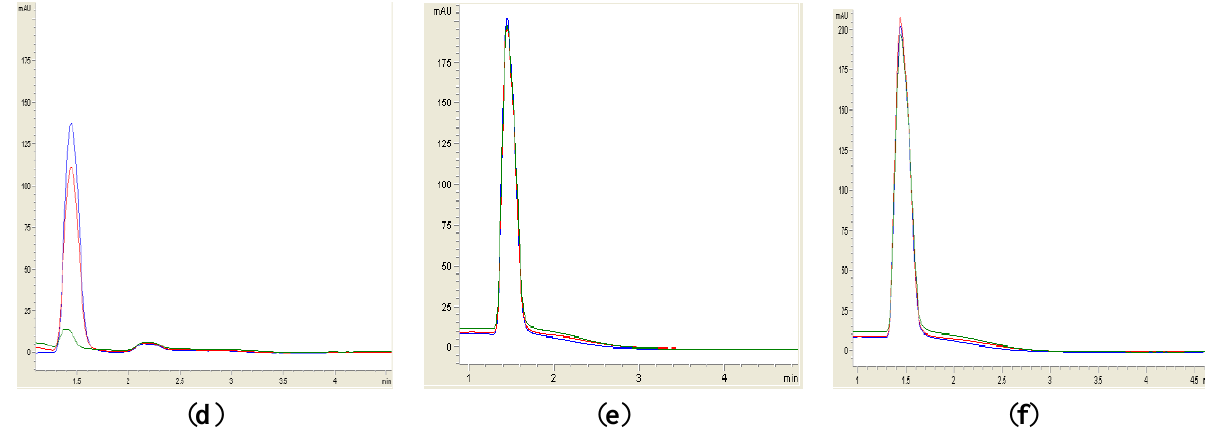
Figure 4. RRLC analysis of 3-oxo - C6-HSL degradation. Residual 3-oxo - C6-HSL